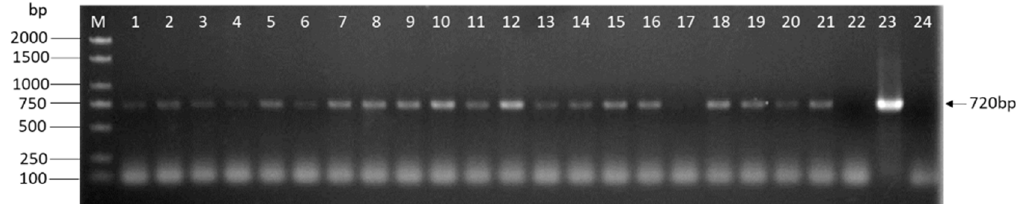
Figure 5. PCR analysis of L. edodes transformants. The genomic DNA of the potential transformants was subjected to PCR amplification of eGFP contained in the T-DNA regions. The size of the expected PCR product is indicated on the right. Lanes: M: 1kb DNA Ladder (TSINGKE, Beijing, China); 1–21: Different hygromycin-resistant transformants after the third selection; 22: Untransformed W1; 23: Plasmid DNA; 24: ddH 2 O.